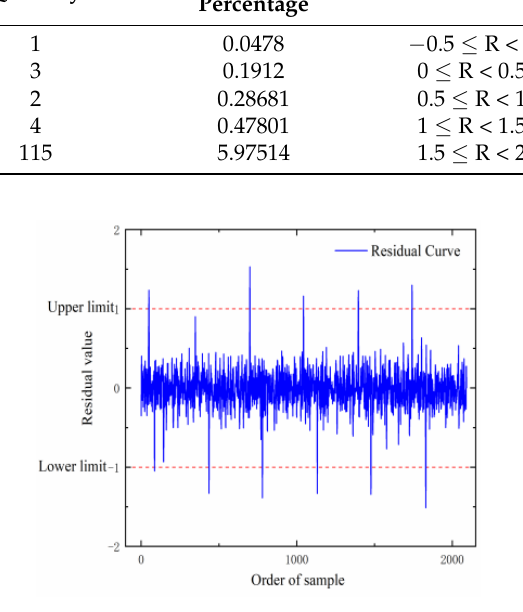
Figure 12. Normal operating condition residual value curve. Table 8. Statistical Table of Residual Values under Normal Working Conditions.